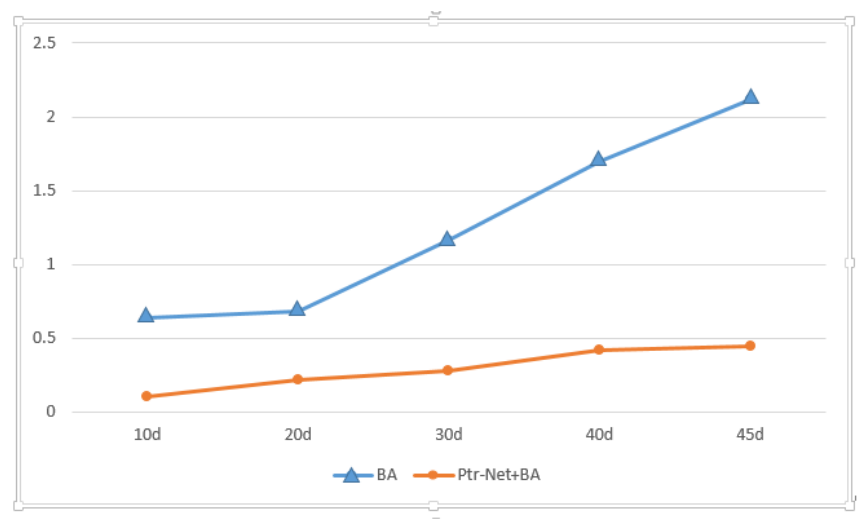
Figure 19. Time graphs of the two algorithms for solving the maximum clique